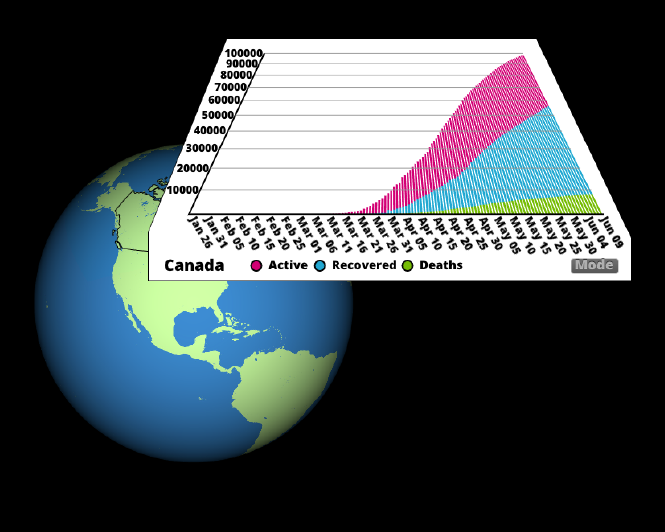
Figure 4. An example of the COVID-19 Visualization Project, displaying Canadian data in a slanted perspective chart